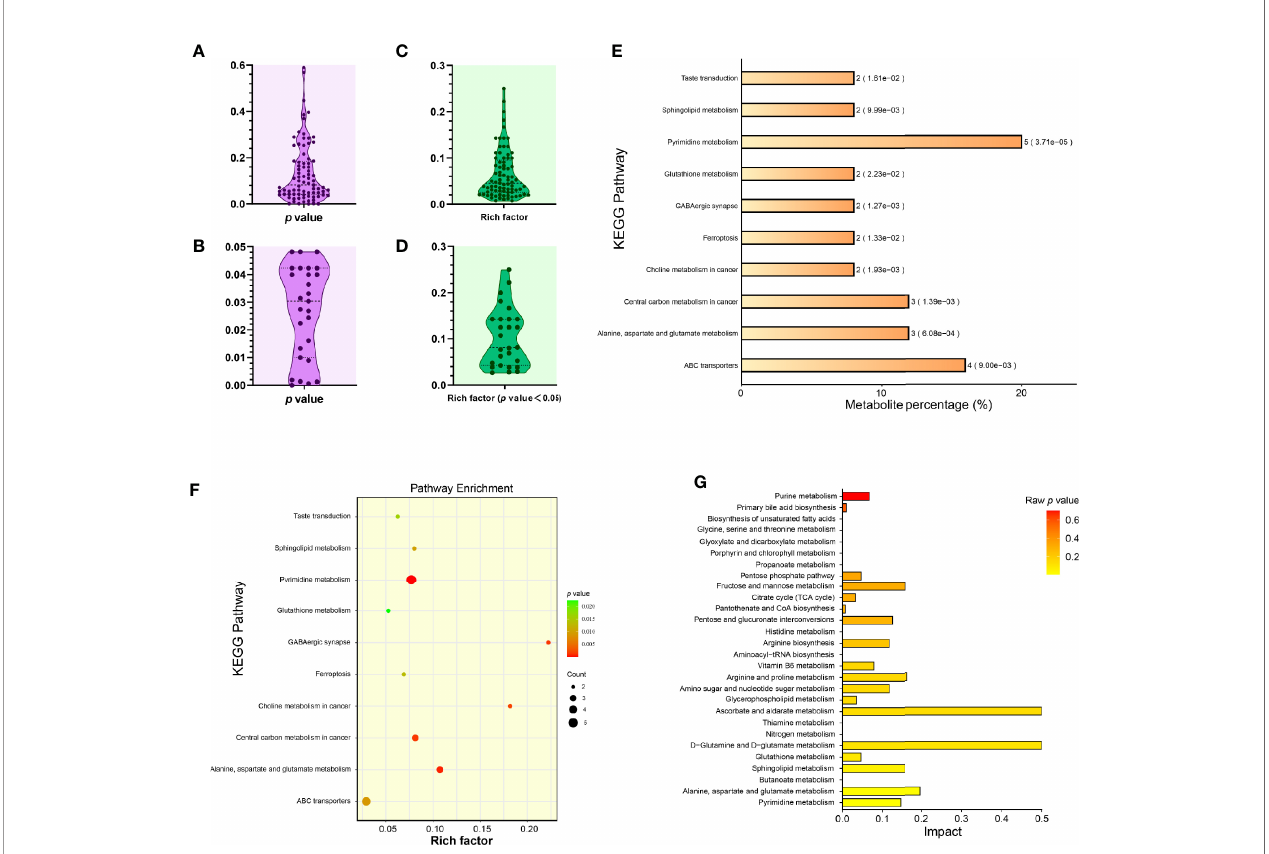
FIGURE 4 | Enrichment analysis of KEGG metabolic pathways related to signi fi cantly differential metabolites. Distribution of p values corresponding to all identi fi ed KEGG pathways (A) . Distribution of p values corresponding to signi fi cantly differential KEGG pathways (B) . Distribution of rich factors corresponding to all identi fi ed KEGG pathways (C) . Distribution of rich factors corresponding to signi fi cantly differential KEGG pathways (D) . Histogram of top-10 statistically signi fi cant KEGG pathways (E) . Each bar is followed by the number of signi fi cantly differential metabolites with the corresponding p value. Metabolite percentage = Count/List Total ( Supplementary File 4 ). Bubble plot of top-10 statistically signi fi cant KEGG pathways (F) . Rich factor = Count/Pop Hit ( Supplementary File 4 ). The greater rich factor represents the greater degree of KEGG enrichment. “ Impact ” comparison among KEGG pathway enrichments (G) . The “ Impact ” means the importance value of metabolic pathways obtained from topological analysis using the MetaboAnalyst